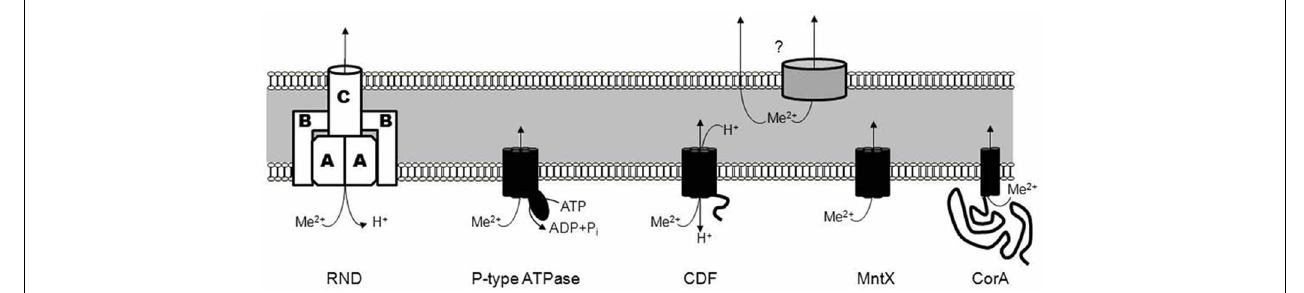
FIGURE 1 | The different families of metal exporters. The different families of metal exporters include the Resistance-Nodulation-Cell division (RND) type transporters, the P-type ATPase family (forming a covalent phosphorylated intermediate), the Cation Diffusion Facilitator (CDF) family, the MntX